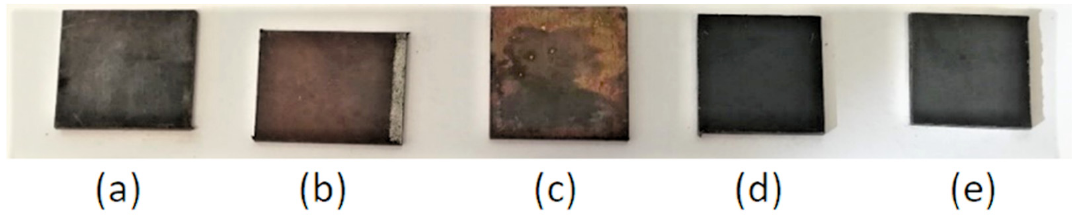
Figure 3. Image of samples treated with solution 1 with different immersion times: ( a ) 15 min, ( b ) 30 min, ( c ) 50 min, ( d ) 75 min, ( e ) 90 min.